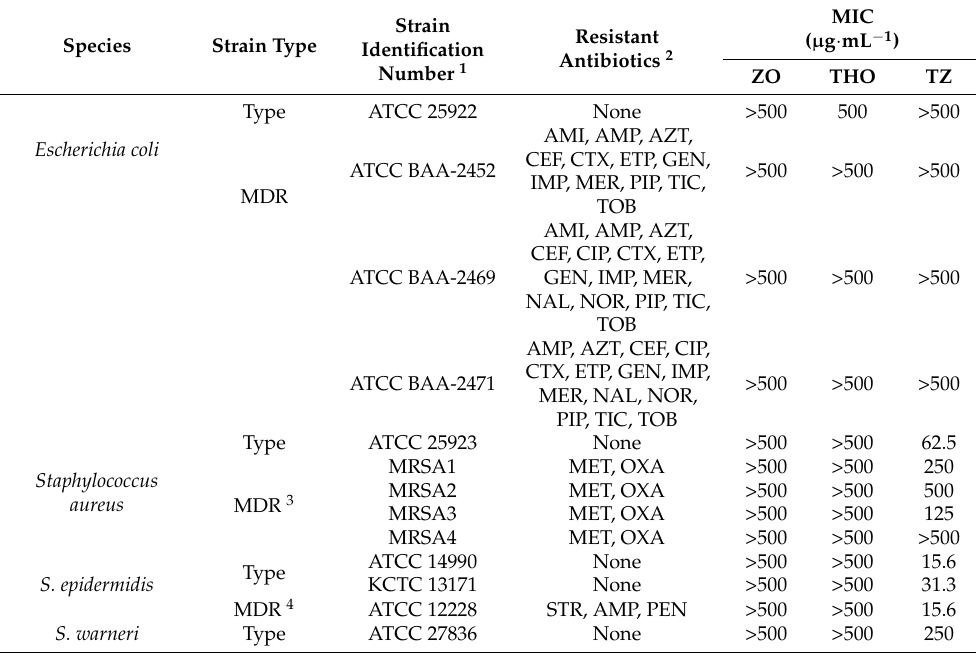
Table 1. Minimum inhibitory concentrations (MICs) of ZO, THO, and TZ NC against Gram-negative E. coli and Gram-positive Staphylococcus